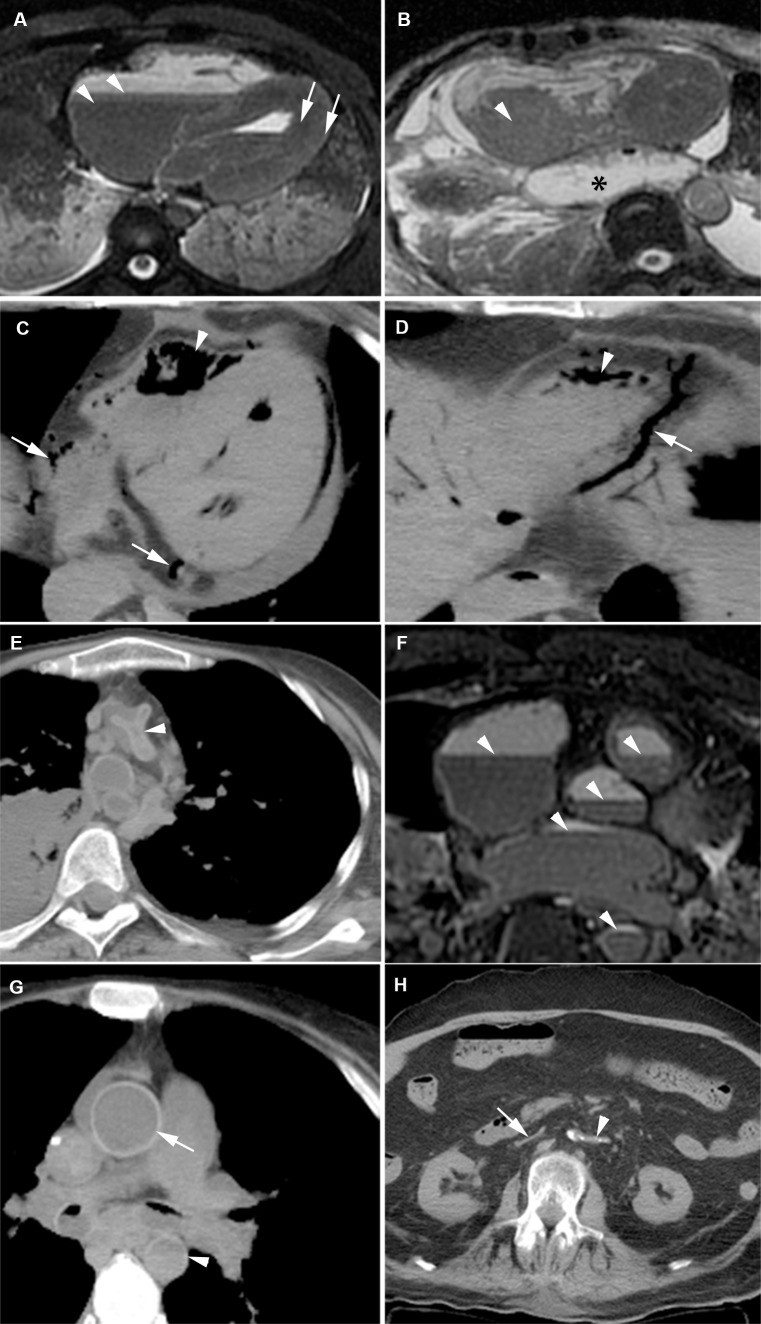
Postmortem imaging features of the heart and large vessels.(A) T2w PMMR: Sedimentation of blood in the heart chambers (arrowhead). T2 signal decay from subepicardial to subendocardial myocardium (arrows). (B) T2w PMMR: Postmortem clotting in the right atrium (arrowhead). Additional finding: a mediastinal herniation of the stomach (asterisk). (C/D) PMCT: Extensive air in the right and left ventricle (arrowheads) and coronary veins (arrows). (E) PMCT: Collapsed ascending aorta (arrowhead). (F) T2w PMMR: Sedimentation of the blood (arrowheads), the plasma layer becomes hyperintense and the dependent layer becomes hypointense. (G) PMCT: Relatively hyperdense aortic wall (arrow) as a result of sedimentation. This is best seen in the ascending aorta. The descending aorta shows a sedimentation level with a hyperdense aspect of the anterior vessel wall (arrowhead). (H) PMCT: Complete collapse of the abdominal aorta (arrowhead) and vena cava inferior (arrow).